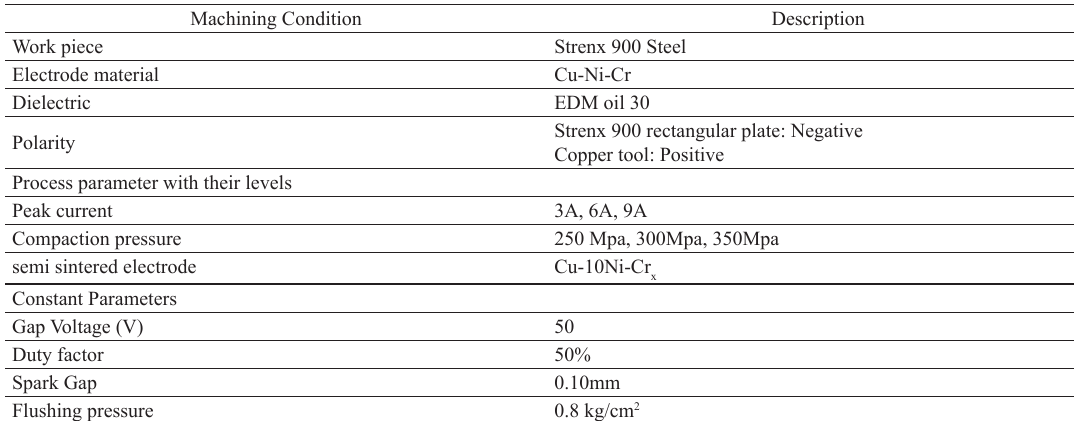
Table 2. Control factors and their